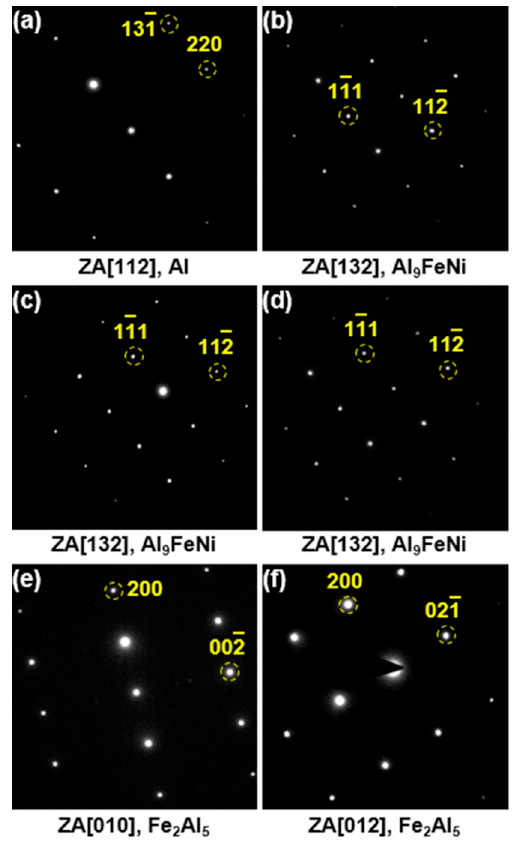
Figure 7. Diffraction patterns obtained from areas denoted by 1–6 in Figure 6: ( a ): 1; ( b ) 2; ( c ) 3; ( d ) 4; ( e ) 5; ( f ) 6.